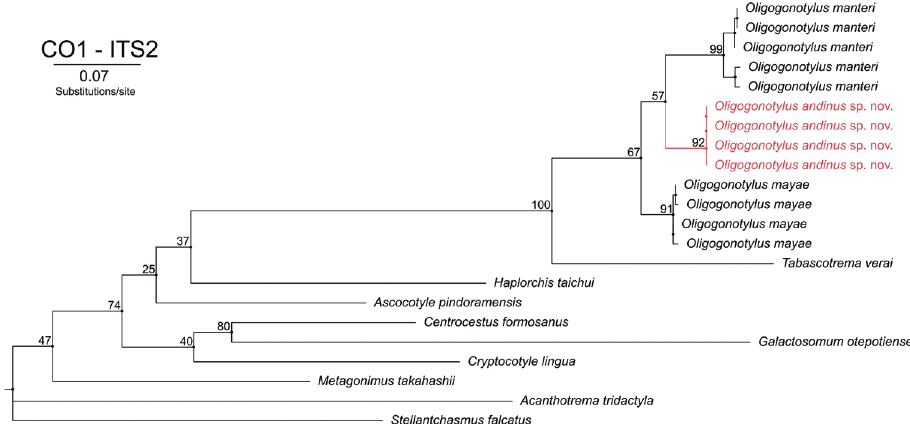
Figure 7. Phylogenetic relationships of COI and ITS2 concatenated sequences of Oligogonotylus andinus sp. nov., Oligogonotylus manteri , and Oligogonotylus mayae . Phylogenetic tree reconstructed using the maximum-likelihood method based on the general time reversible with proportion of invariable sites and gamma distribution model (GTR+I+G) model. Numbers on the branches correspond to the ultrafast bootstrap approximation support values. Terminals in red correspond to the sequences obtained in this report. Diagram made with Garli IQ-TREE